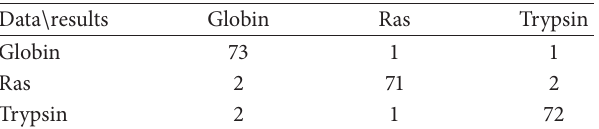
Table 8: Confusion matrix using neural network classifier on dataset 2.